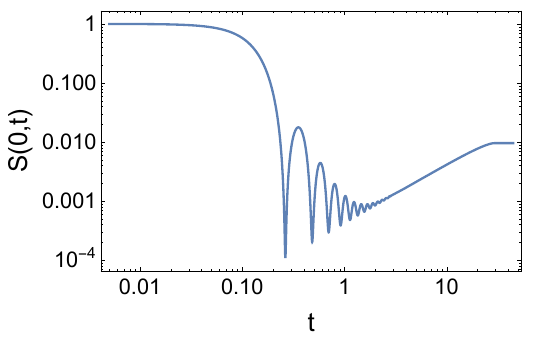
Figure 11 . Spectral form factor in the GUE of size L = 105 at (cid:12) = 0. The (cid:12)gure shows a plot of the analytic function